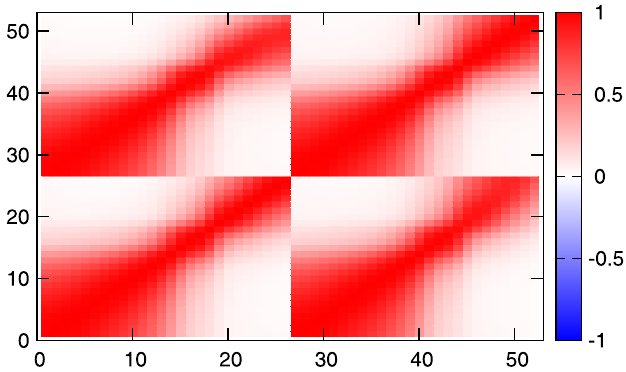
Fig. 9. Correlation matrix of decay heat uncertainties after 100 000-second irradiation and